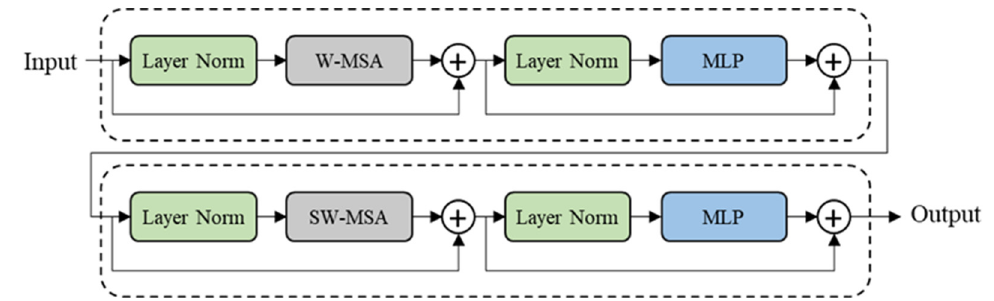
Figure 7. The structure of two successive Swin Transformer